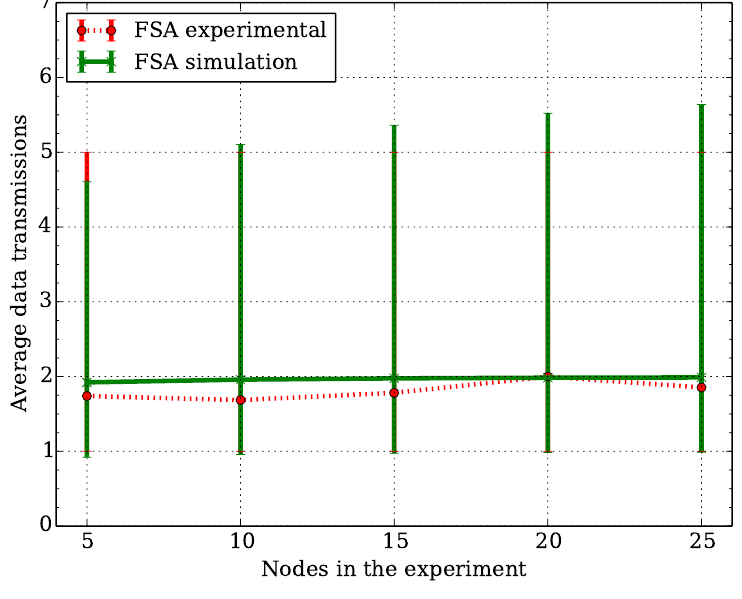
Figure 5. Average number of data packet transmissions using Frame Slotted ALOHA (FSA). Each point is the average of 100 experiments and the error lines are the minimum and maximum values. If the number of slots per frame k is equal to the number of nodes n , on average data packets need to be retransmitted twice in order to be